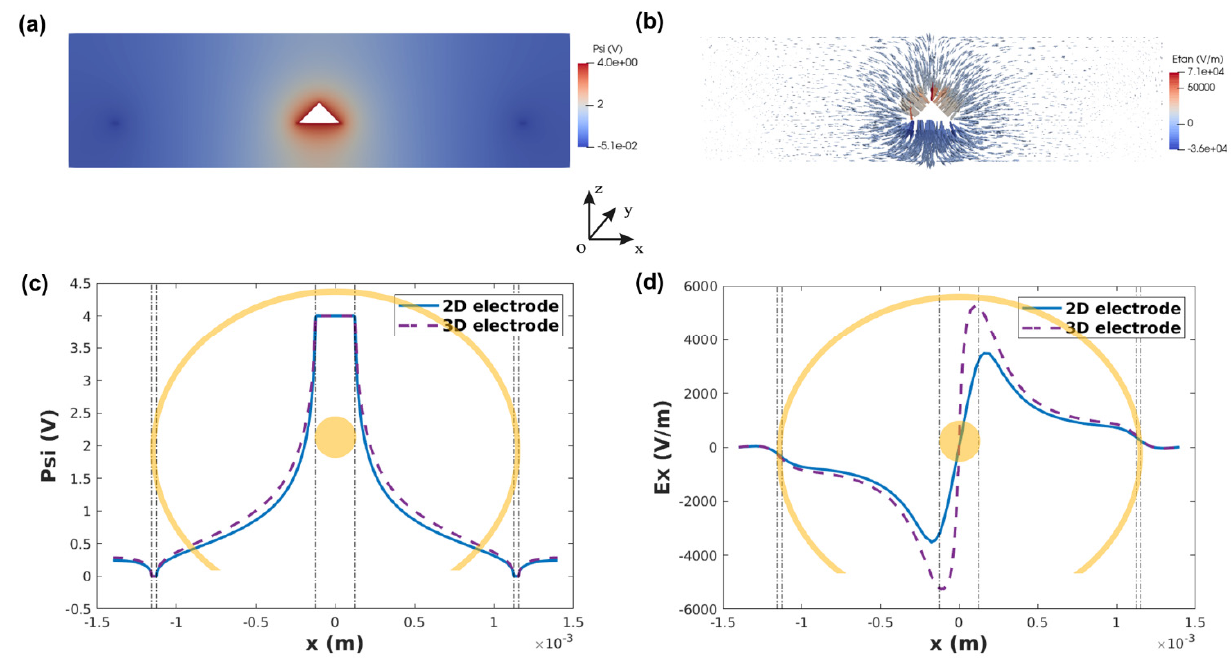
Figure 5. ( a ) Potential distribution and ( b ) tangential electric field distribution on the cross-section of -xoz plane. ( c ) 2D/3D potential comparison along x axis at z = 0 µm and ( d ) electric field comparison along x axis at z = 150 µm.